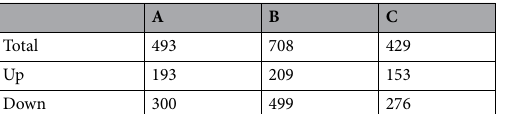
Table 2. Number of differentially expressed transcripts in each condition, compared to Condition D.